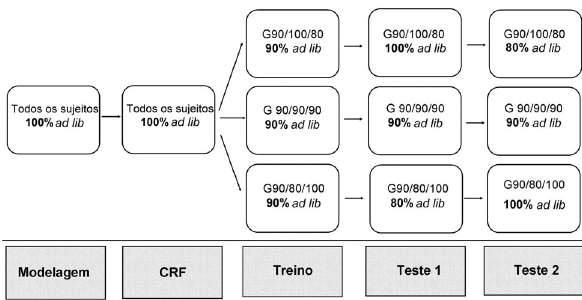
Figura 1 . Grupos, níveis de privação e fases às quais os animais